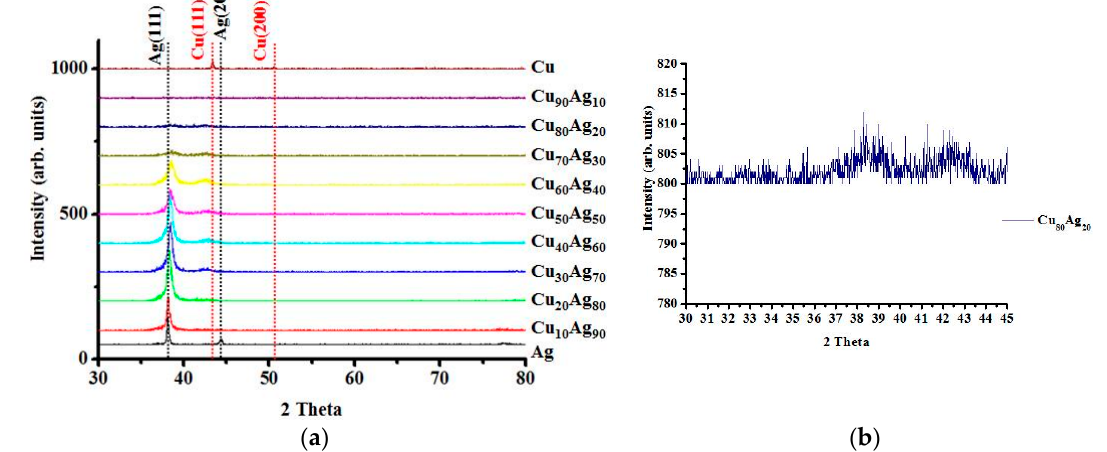
Figure 1. X-ray diffractometry (XRD) patterns of ( a ) as-deposited Cu–Ag films as a function Cu:Ag atomic ratios; ( b ) the enlarged spectrum of sample Cu 80 Ag 20. It contains Ag (111) and Cu (111) orientations.